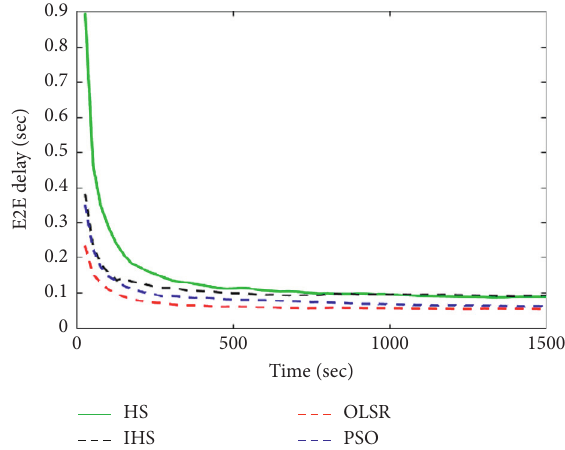
Figure 9: E2E Delay simulation results. Figure 10: Overhead simulation